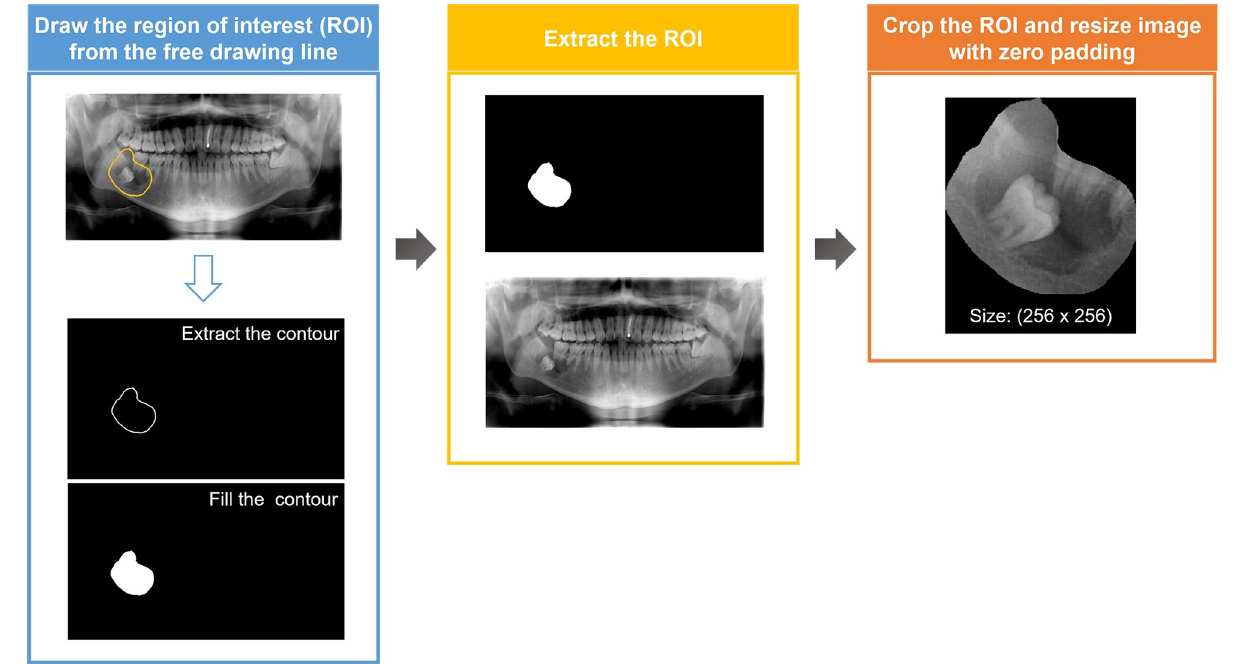
Fig 2. Schematic representation of the pre-processing steps in data preparation.